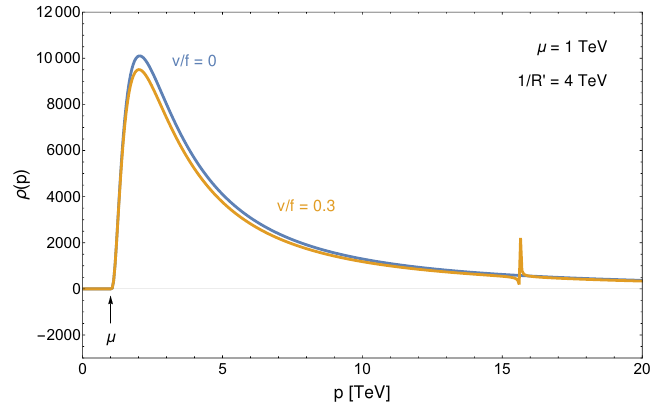
Figure 16 . Spectral density for W=W 0 mix with (cid:22) = 1 TeV ; 1 =R 0 = 4 TeV.